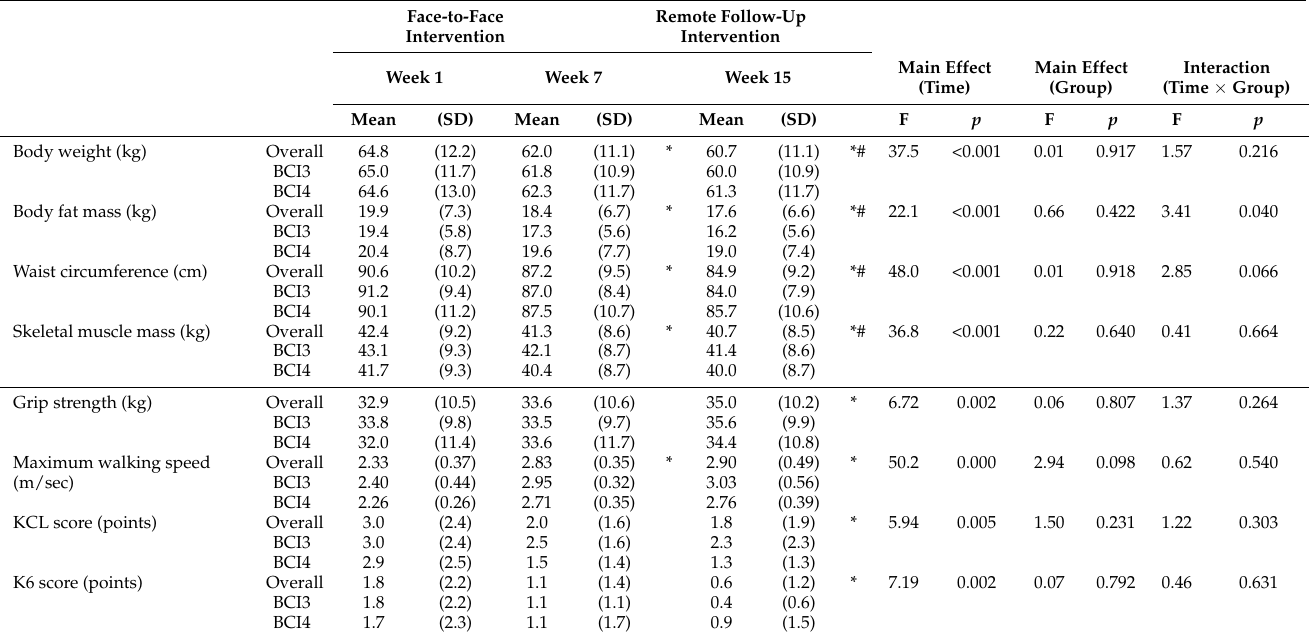
Table 2. Body weight, body compositions, fitness, and psychological factors during face-to-face and remote follow-up